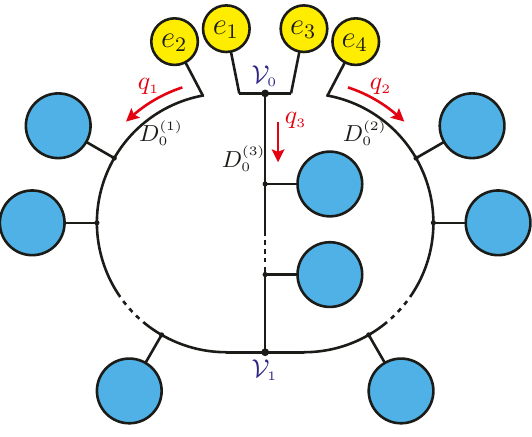
Figure 4 . Insertion of pseudo wave functions into an irreducible two-loop